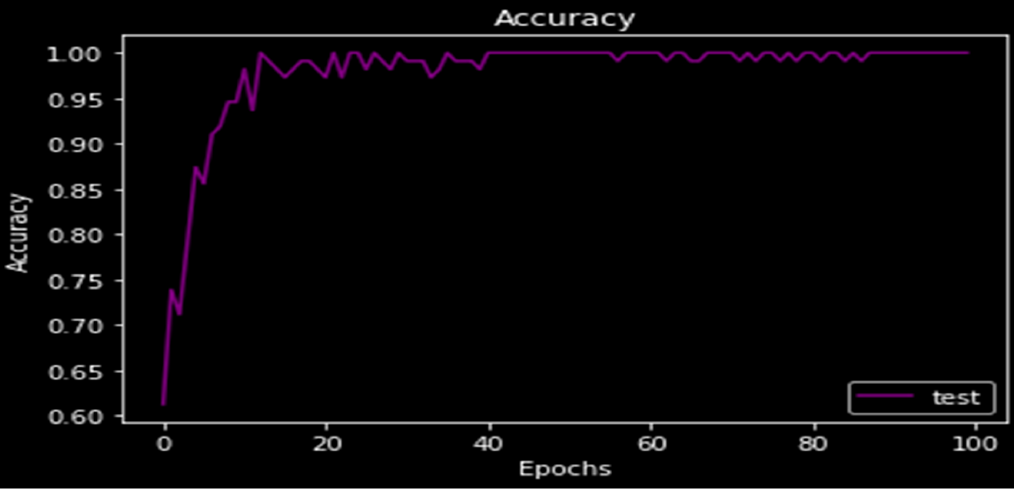
Table 3. Results using RT-GAN algorithm .